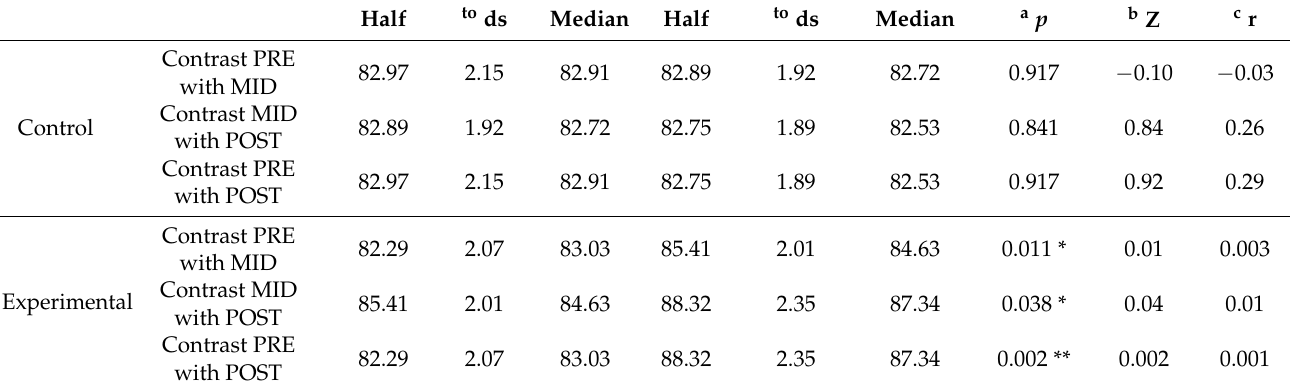
Table 5. Comparison within each group of the results in the PRE Test, MID Test, and POST Test. Half to ds Median Half to ds Median a p b Z c r